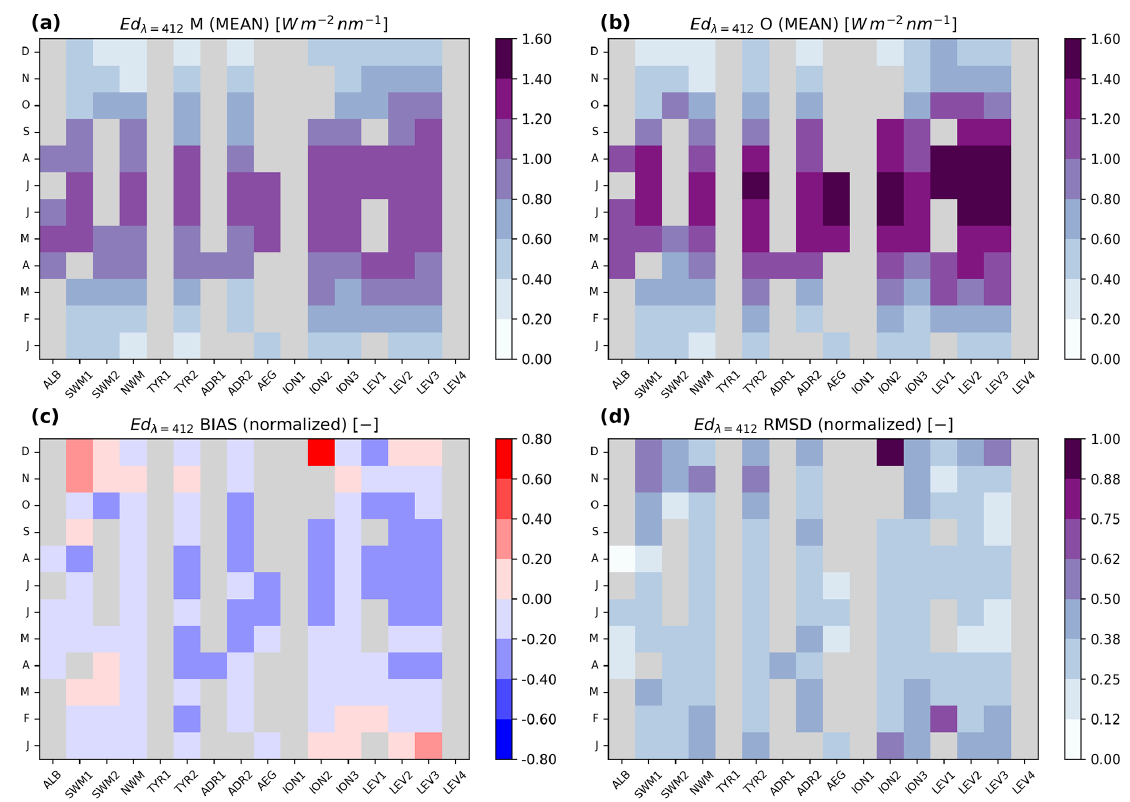
Figure 9. Same as Fig. 8 for E d (λ = 412 , 0 − )